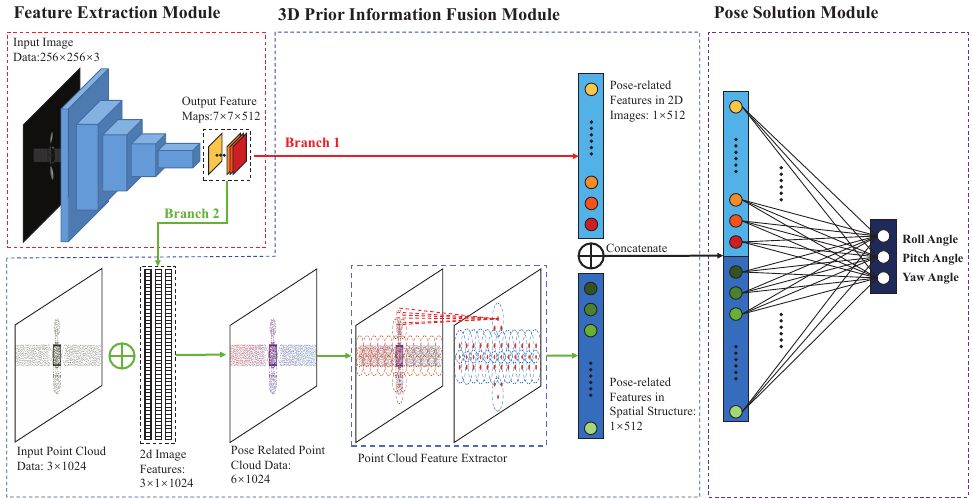
Figure 2. The pipeline of the proposed method. First, we input the images to the features extraction module to extract the features. Then, we input features to the 3D prior information fusion module, which consists of two branches. Branch 1, shown in red lines, extracts the features corresponding to the 2D images. Branch 2, shown in green lines, extracts the features related to the spatial structure by combining the 3D model. The features extracted by the two branches are concatenated. Finally, the concatenated module is input to the pose solution module to solve the